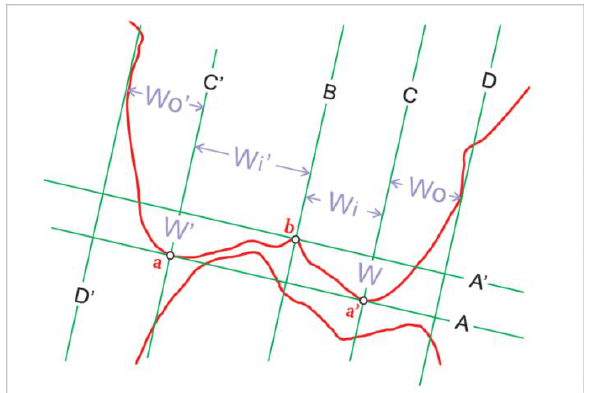
Figure 8. Odontometry on a tooth contour in